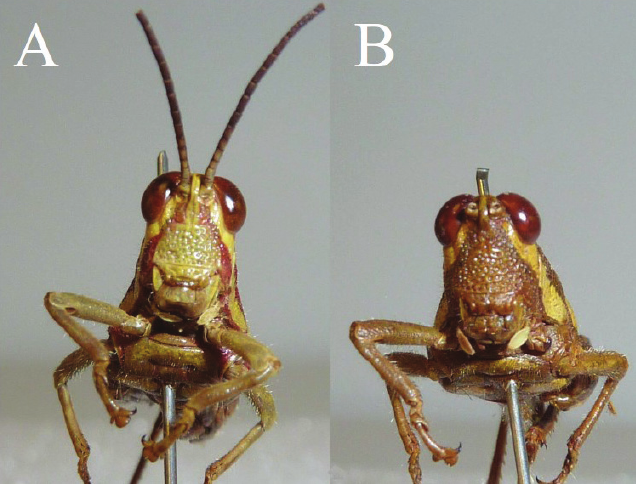
Fig. 2. Facial coloration of the female holotypes of A. Mopla rubra and B. M. guttata , showing the expanded terminal segments of the labial palps, and the difference in structure of the frontal